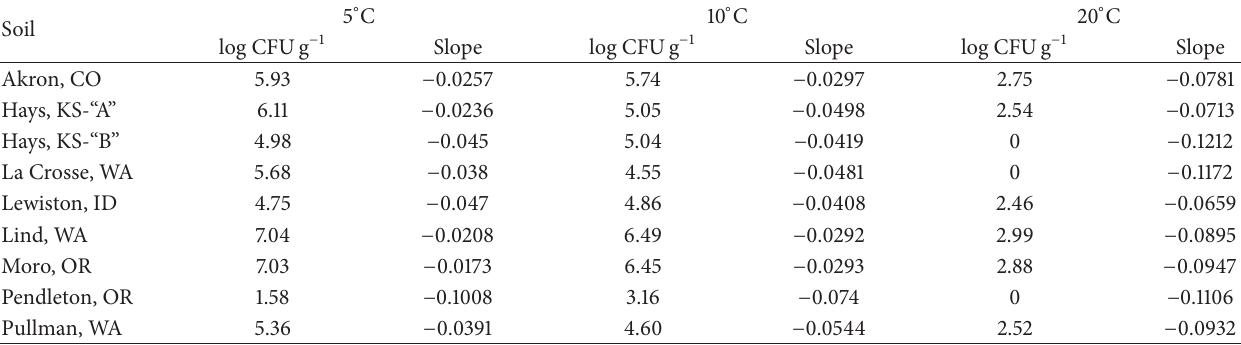
Table 4: Pseudomonas fluorescens D7rif survival and slope of trendline after 63-day incubation at 5, 10, and 20 ∘ C, averaged across